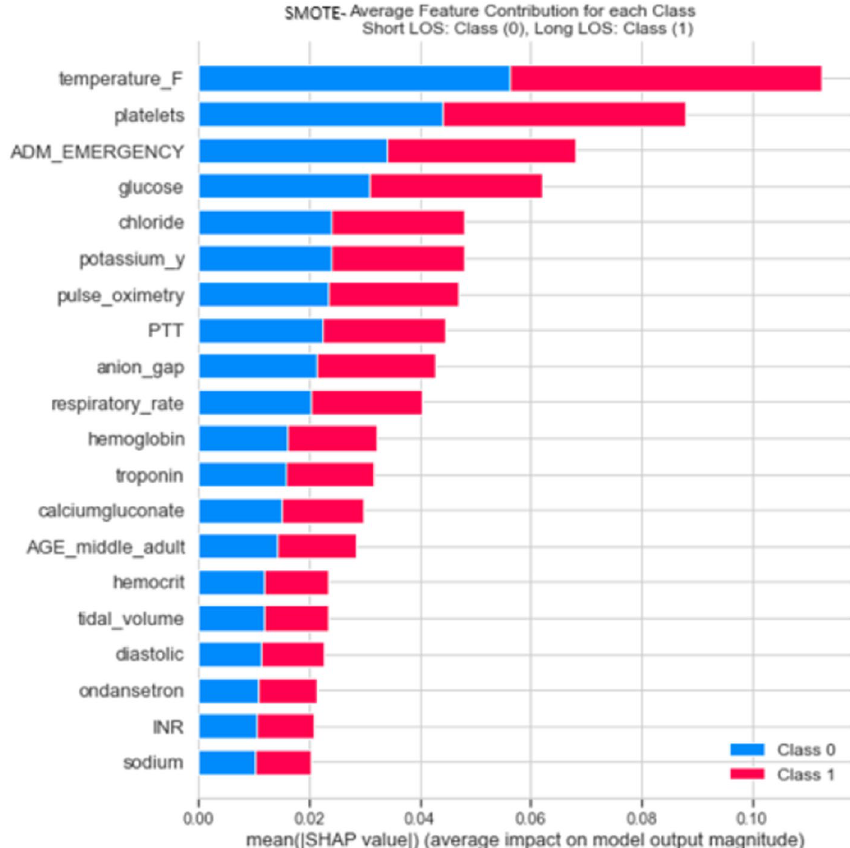
Figure 2. SHAP (mean value; the impact of each model’s (features) on the model output magnitude for selected Class-balancing methods with